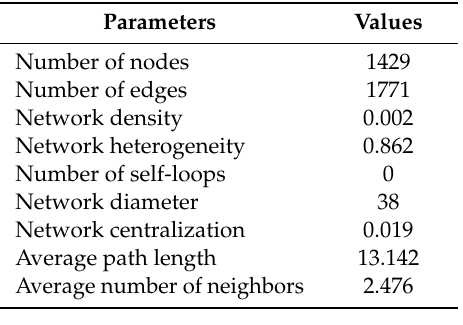
Table 2. General properties of the constructed network.